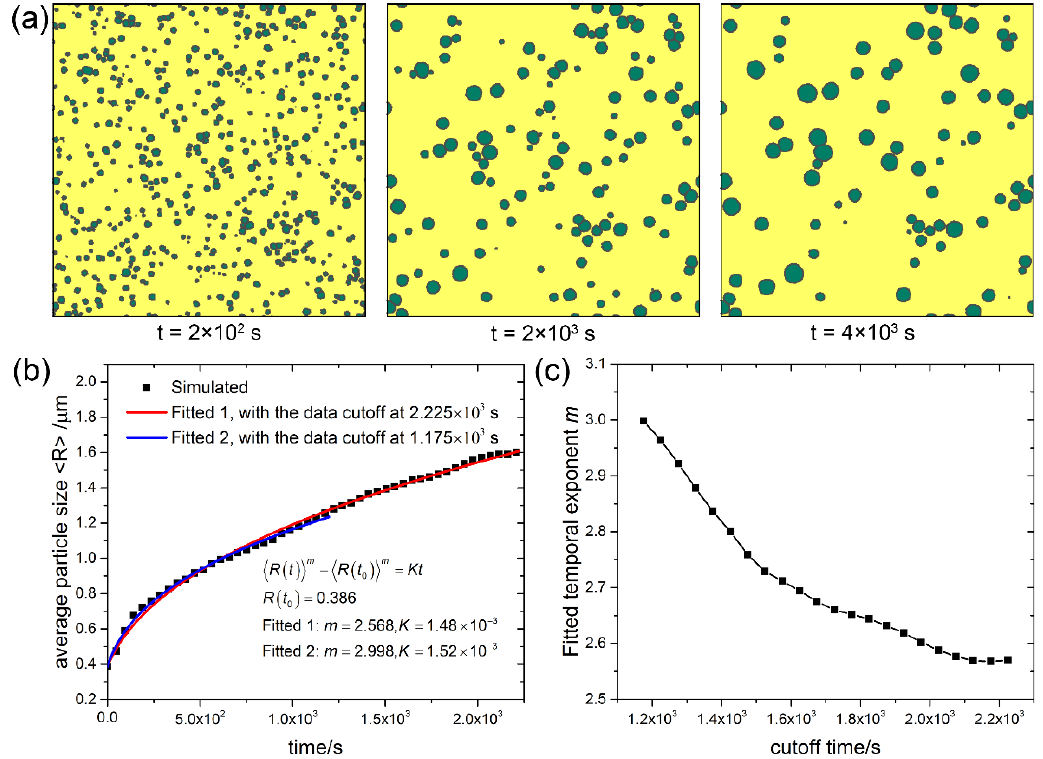
Figure 2. System with f v = 10%. ( a ) Microstructure evolution; ( b ) Average particle size vs. time; ( c ) Fitted temporal exponents m of the power law (cid:104) R ( t ) (cid:105) m − (cid:104) R ( t 0 ) (cid:105) m = Kt at different cutoff times. Simulation grid is 1000 × 1000 with the cell size of 0.1 μm.